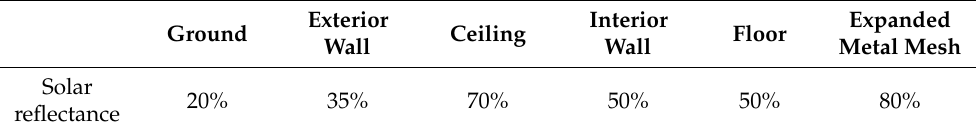
Table 6. Material settings for DIVA of an office